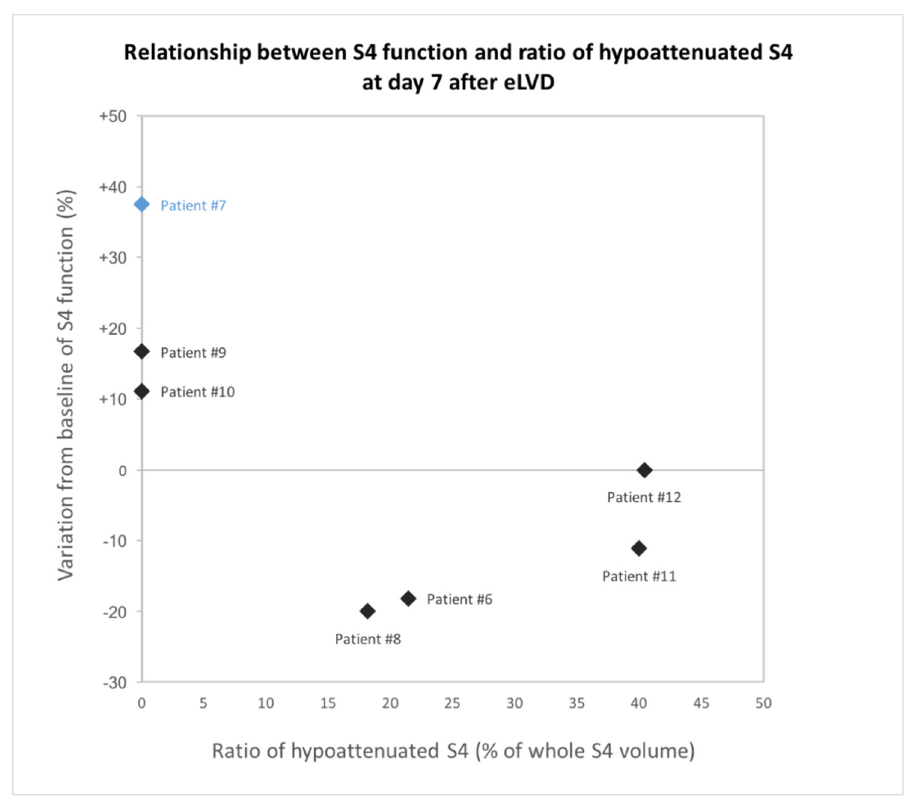
Figure 5. Graph representing the relationship between S4 function and ratio of hypoattenuated S4 on CT in each patient at day 7 after eLVD. The only patient without hypoattenuated area in S4 on CT at day 1 is presented in blue, other patients in black.